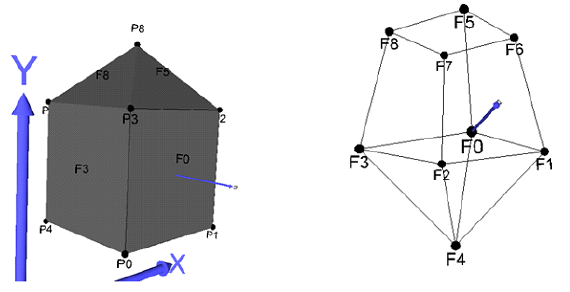
Figure 3: The dual graph of the boundary of a